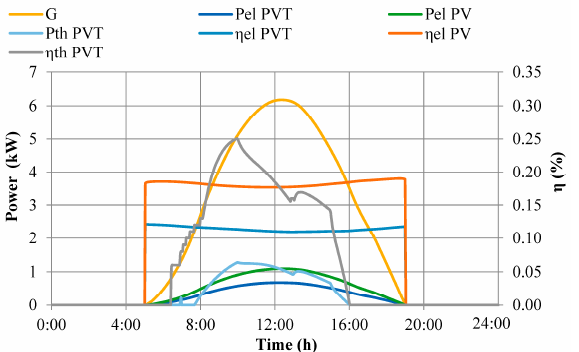
Figure 7. Daily power (left) and efficiency (right).